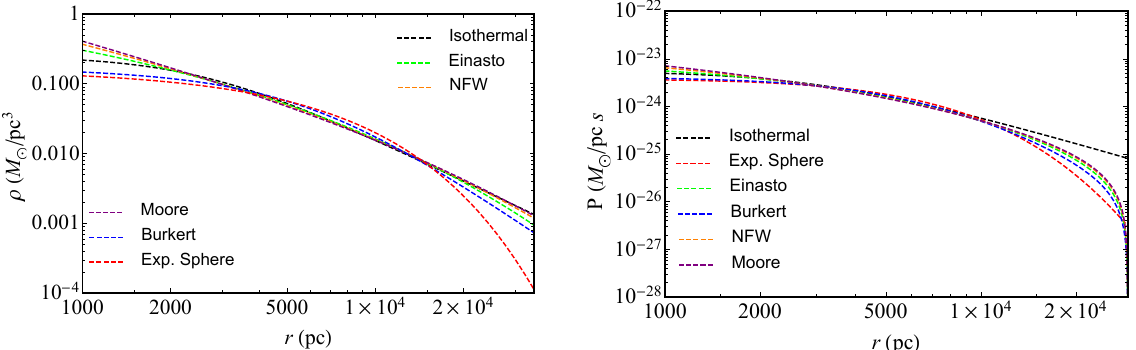
Figure 4. Color online. Left panel: Logarithmic density profiles of DM in the halo. Right panel: Logarithmic pressure profiles of DM in the